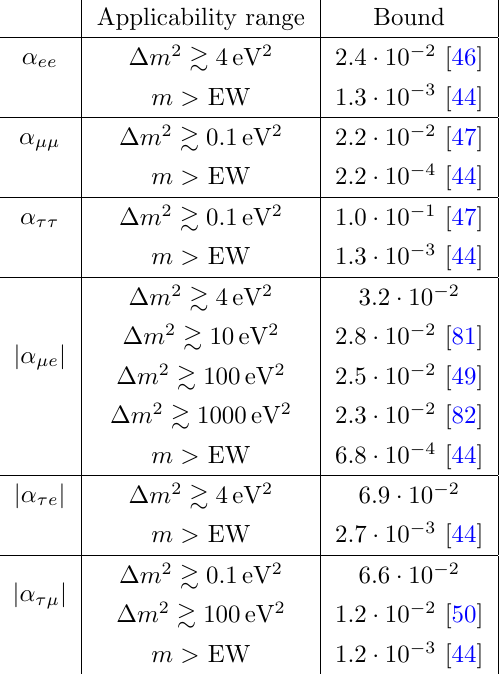
averaged-out regime for (cid:1) m 2 & 1000 eV 2 . Nevertheless, similar bounds from NOMAD [49] j (cid:11) j < 2 : 5 (cid:1) 10 (cid:0) 2 and KARMEN [81] j (cid:11) e(cid:22) (cid:1) m 2 & 10 eV 2 respectively. NOMAD [50] also gives the most stringent constraints for (cid:11) , valid for (cid:1) m 2 & 100 eV 2 . For (cid:11) (cid:28)(cid:22) the diagonal elements through (cid:11) sterile neutrinos, (cid:1) m 2 (cid:24) 0 : 1 eV 2 , all the direct constraints on the o(cid:11)-diagonal elements from NuTeV, NOMAD and KARMEN fade away. In this case, the strongest bounds are obtained indirectly from the diagonal elements via (cid:11) Open